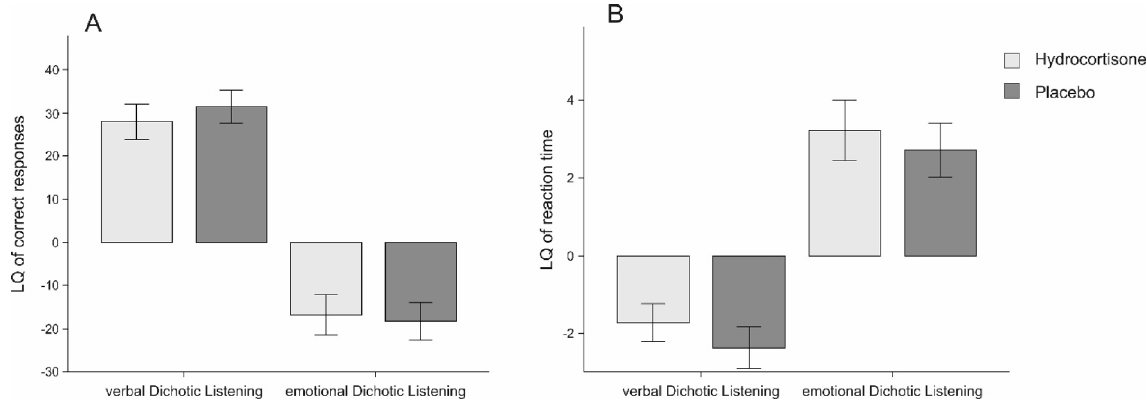
Figure 5. LQs for the verbal and emotional dichotic listening task for number of correct ( A ) and responses mean reaction times ( B ). Error bars represent ± 1